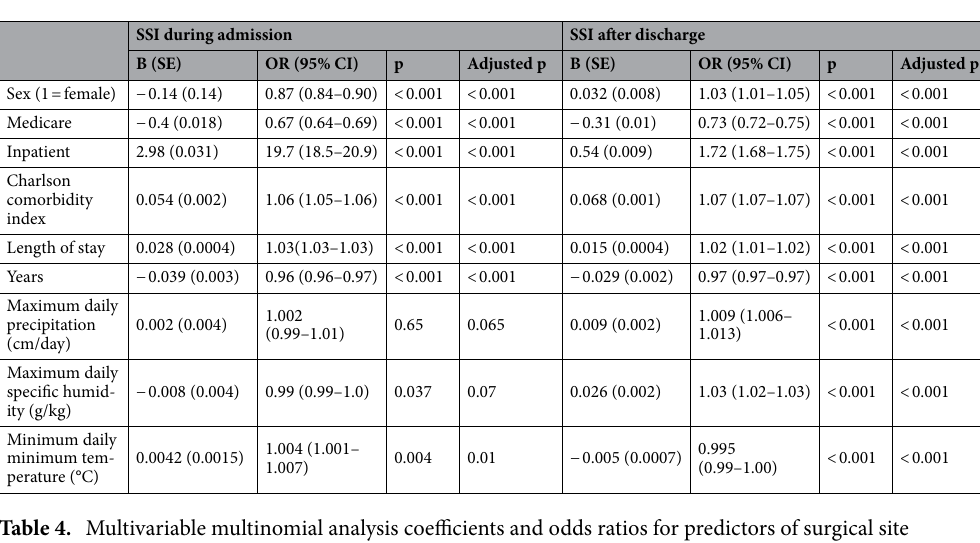
Table 4. Multivariable multinomial analysis coefficients and odds ratios for predictors of surgical site infection. Procedure categories (n = 15) and MSA (n = 393) were included in analysis but omitted from the table. Years are measured from 2007 up to 2014. Adjusted p-values were derived using Holm’s method.